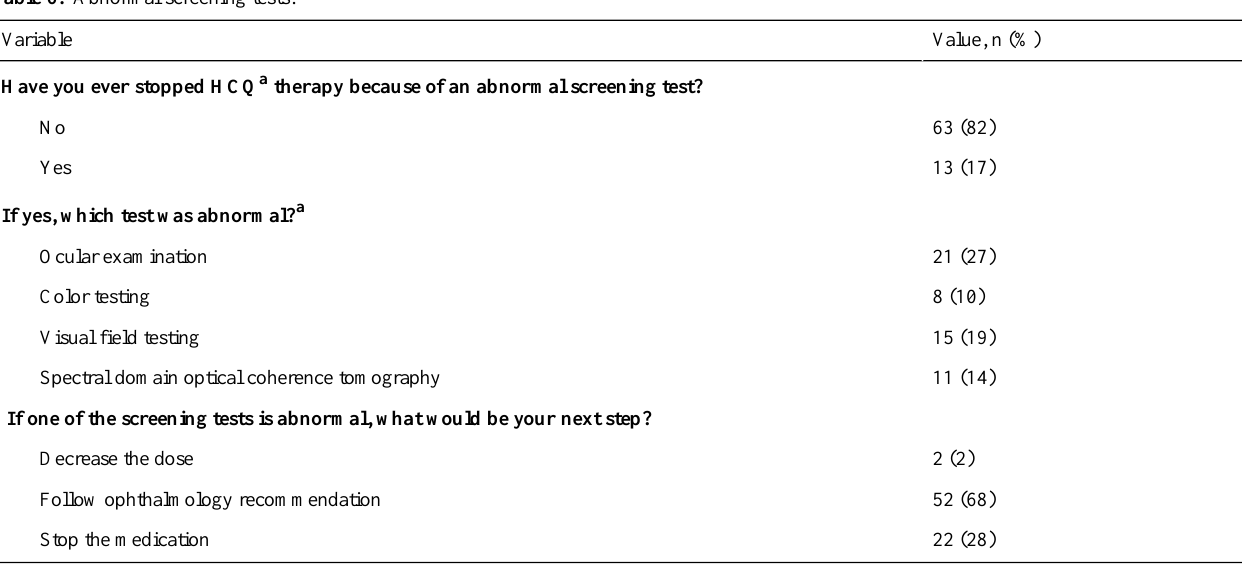
Table 6. Abnormal screening